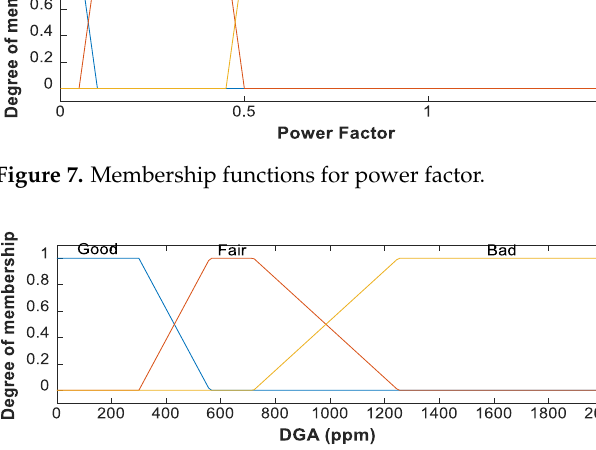
Figure 8. Membership functions for DGA.